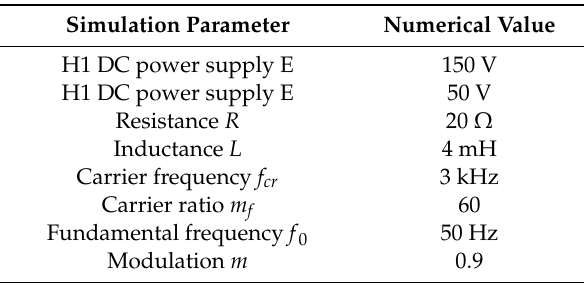
Table 4. Simulation model parameters.